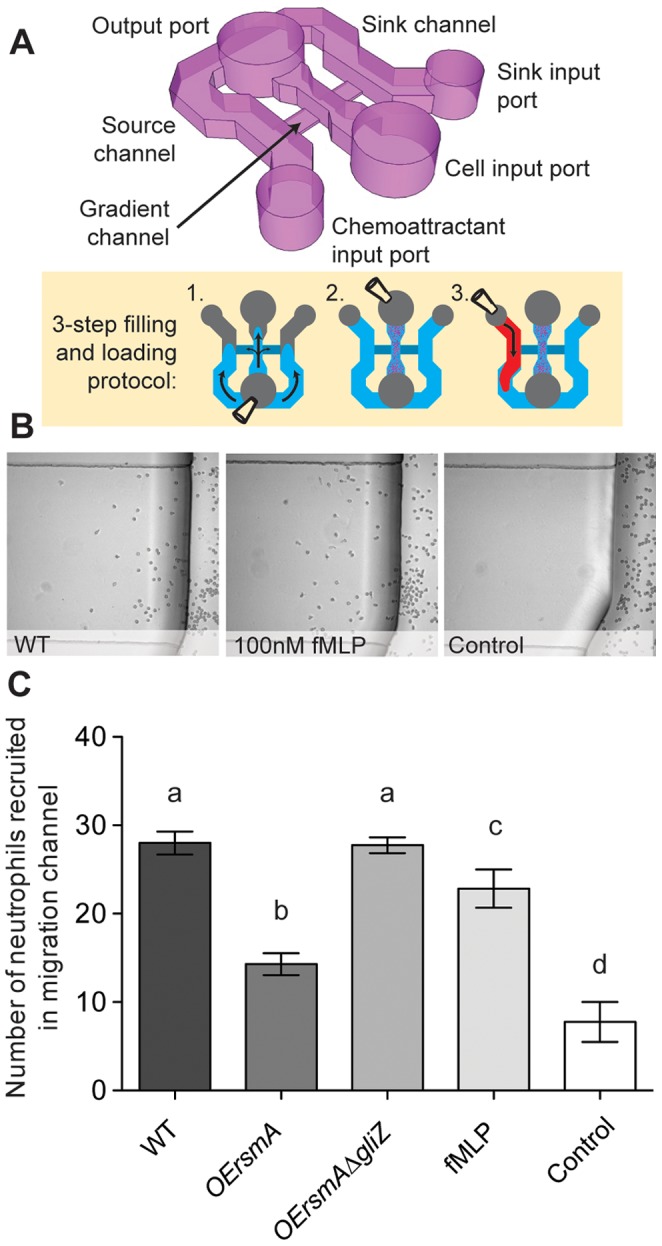
Neutrophil chemotaxis is reduced when exposed to extracts from OErsmA.
A. Schematic of the neutrophil migration platform used. The neutrophils are placed in the center channel; the compound to be tested is placed in one of the side channels, while the other channel acts as a negative control. The device is prepared in 3 steps: (1) filling, (2) adding neutrophils, and (3) adding the fungal culture supernatants. B. Representative microscopy images of the migration area after 1 h incubation. Supernatant of wild type A. fumigatus (AF WT) has chemoattractive properties on par with the known chemoattractant fMLP. C. Quantification of neutrophil recruitment to the crude supernatant of wild type, OErsmA, and OErsmAΔgliZ strains (significant differences at P<0.5 are indicated by different letters).